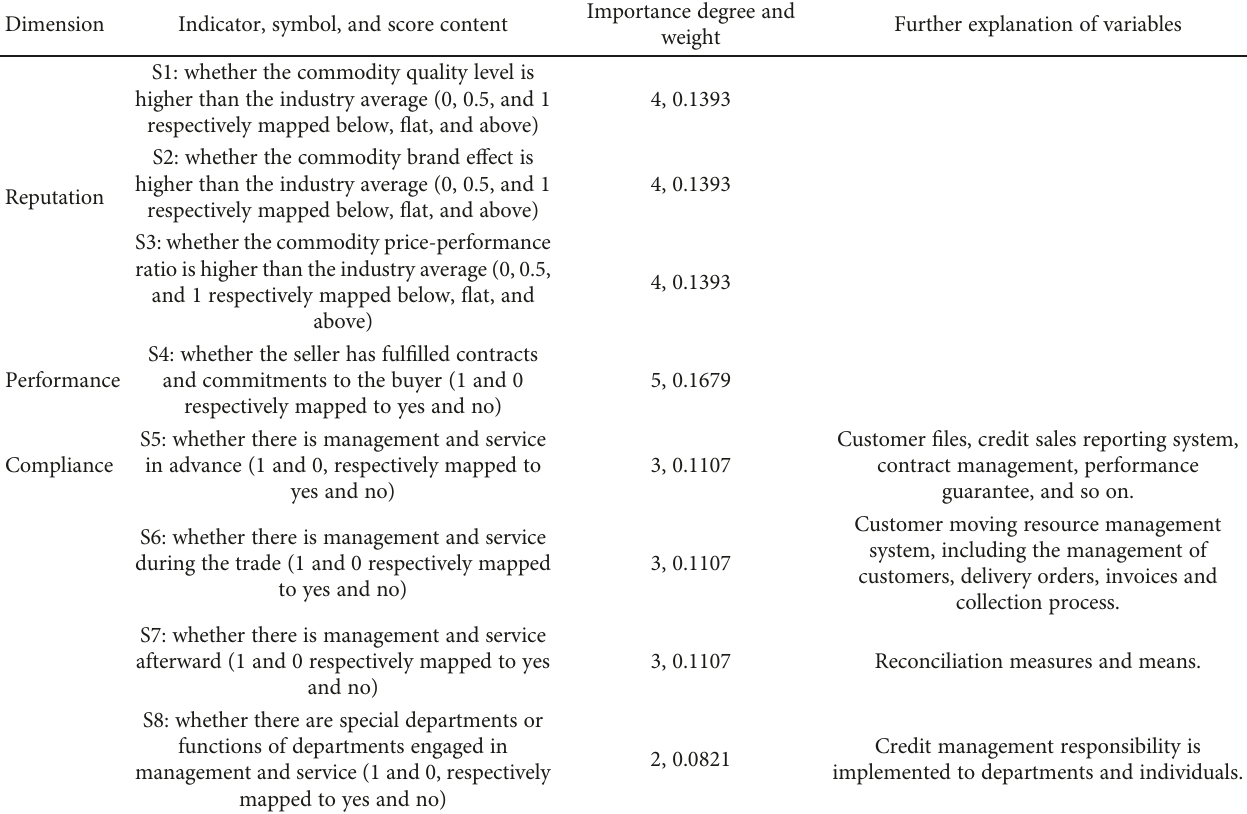
Table 5: Seller ’ s credit management index